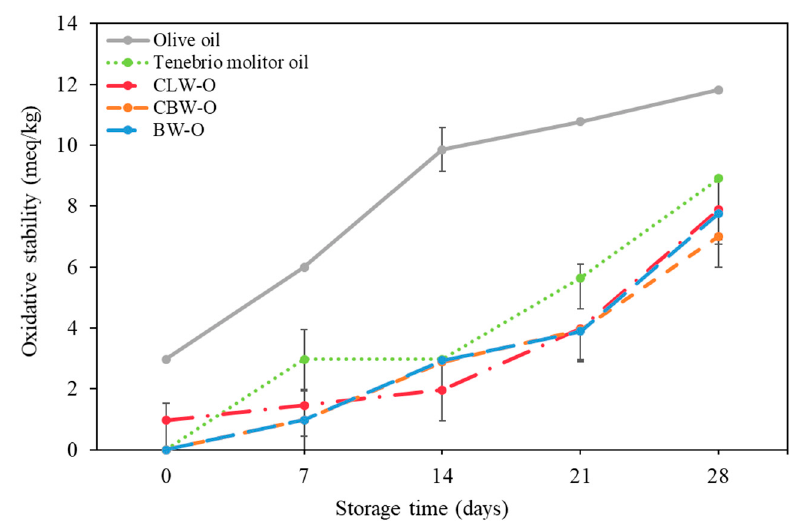
Figure 4. Oxidative stability of olive oil, Tenebrio molitor oil, and oleogels.